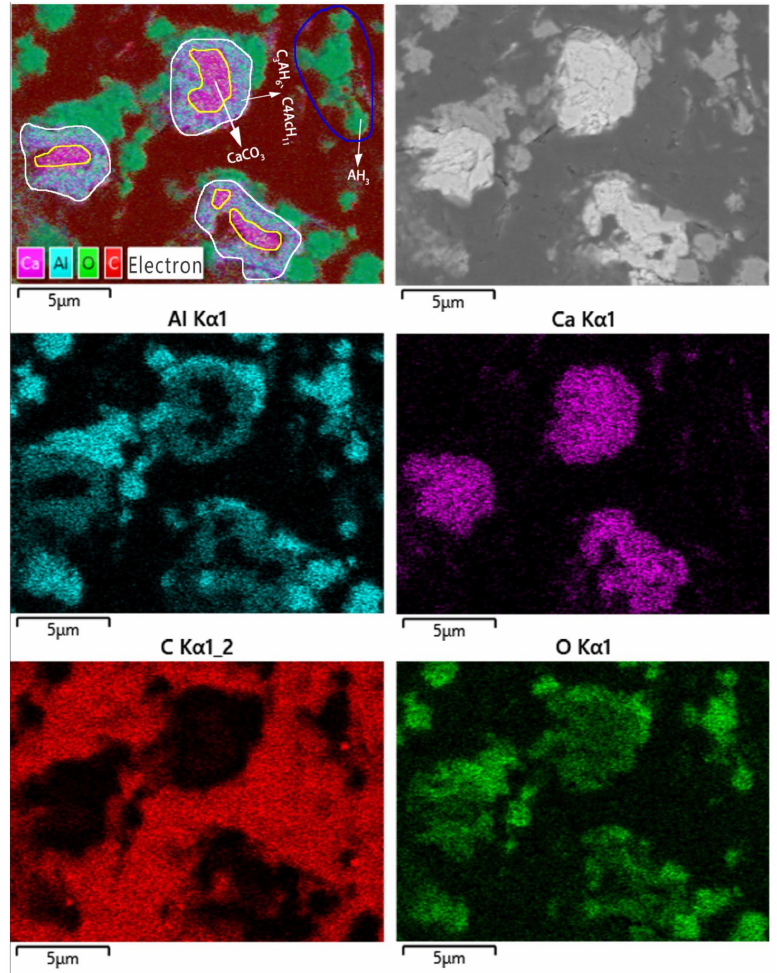
Figure 7. SEM image and EDS mapping of <500 mesh ground calcium carbonate